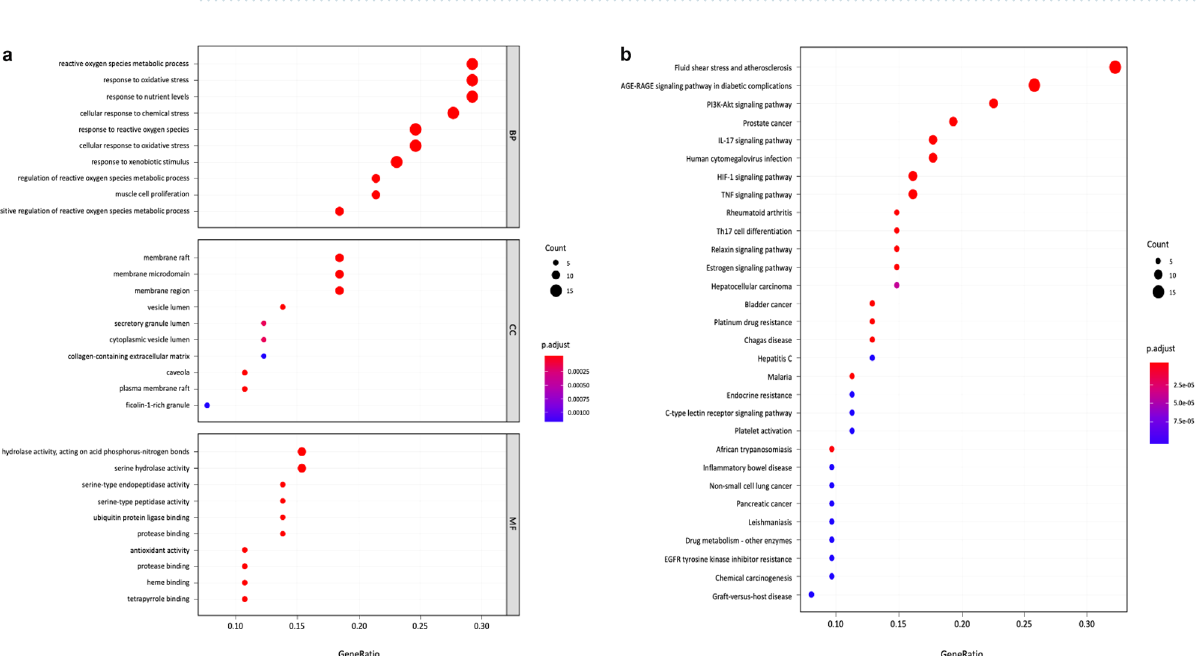
Figure 5. ( a ) The top ten biological process (BP), cell components (CC) and molecular functions (MF) of Gene Ontology (GO) enrichment analysis were listed respectively in order, from top to bottom. ( b ) The common targets were analyzed for Kyoto Encyclopedia of Genes and Genomes (KEGG) pathway enrichment. The importance of top 30 pathways is evaluated and ranked by the bubble